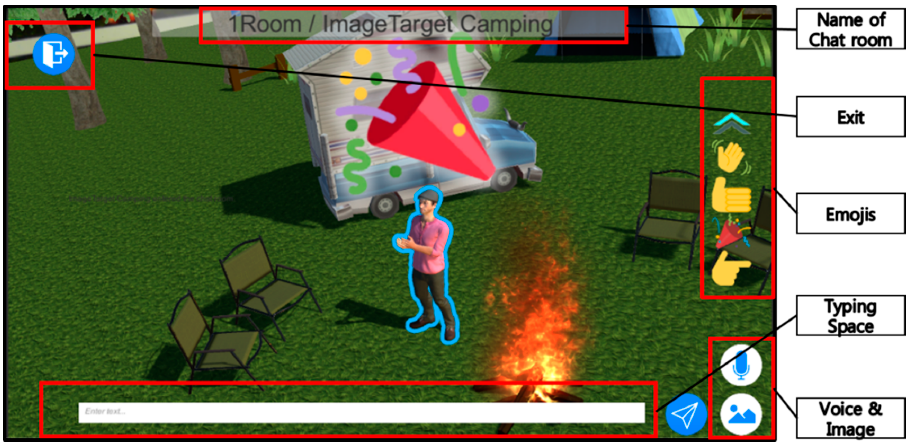
Figure 6. Augmented chat room and characters viewed through marker.